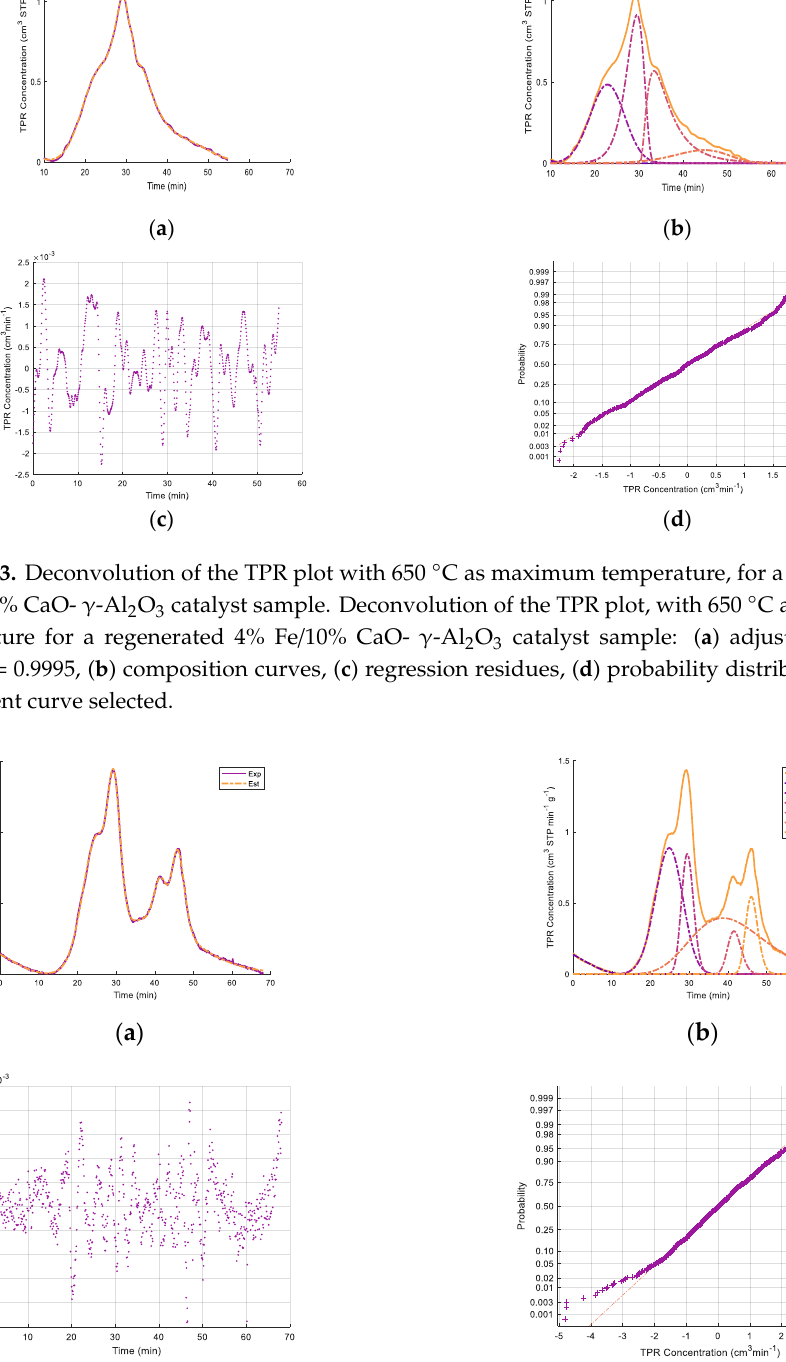
selected. ( c ) regression residues, ( d ) probability distribution of the adjustment curve